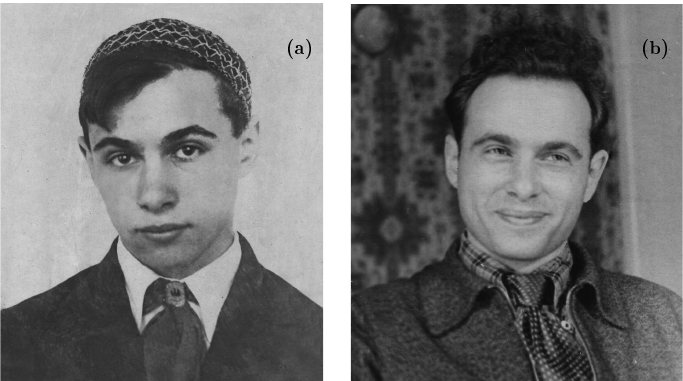
Figure 1. ( a ) 1940. Farewell, school years. ( b ) 15 June 1954. Released after imprisonment, but full of energy and optimism. In Tolmachevo, more than 100 km from Leningrad, where he was allowed to reside. From family archive; courtesy of Arkady and Bella